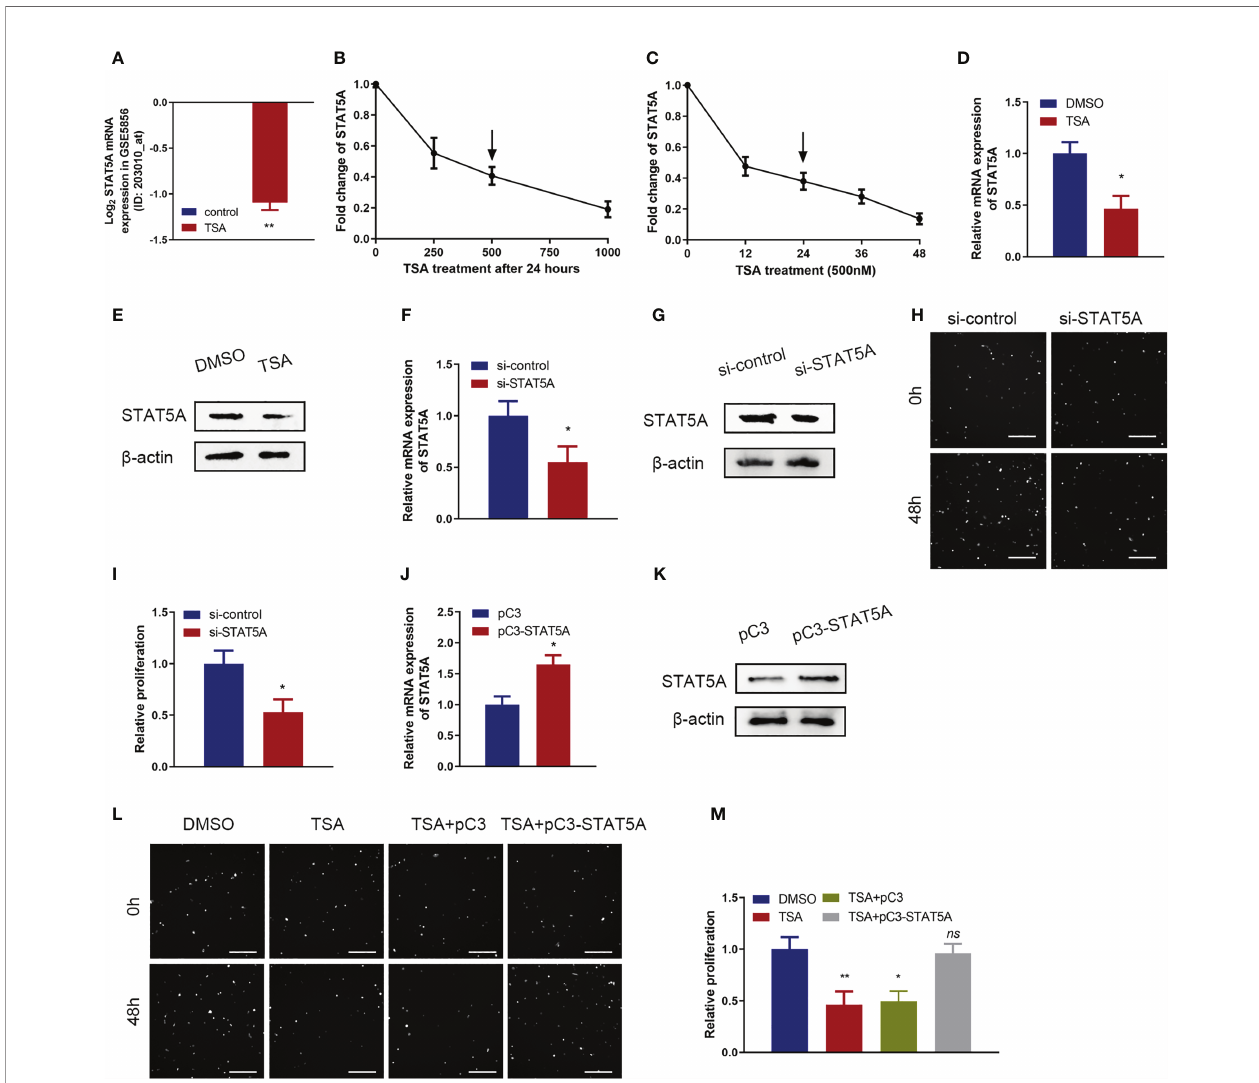
FIGURE 3 | Roles of signal transducer and activator of transcription 5 A (STAT5A) in cell proliferation inhibition of TSA on HUVECs. (A) Fold change of STAT5A expression in the microarray data (#GSE5856). (B, C) HUVECs were incubated with different doses of TSA (B) or for various durations of time (C) . mRNA expression of STAT5A was tested by qRT-PCR. (D, E) STAT5A mRNA level (D) and protein level (E) at 48 h after 500 nM TSA treatment were measured by qRT-PCR and Western blotting assay. (F, G) Knockdown ef fi cacy of siRNA transfection into HUVECs was analyzed by qRT-PCR (F) and Western blotting assay (G) . (H) HUVECs were transfected with si-STAT5A or si-control for 48 (h) Cell proliferation was examined with Cellomics ArrayScan VTI assay. Scale bar 400 m m. (I) Quanti fi cation of the data from (H) . (J, K) HUVECs were transfected with STAT5A plasmid (pC3-STAT5A) or empty plasmid (pC3) and then subjected to qRT-PCR analysis (J) and Western blot analysis (K) . (L) HUVECs were treated with DMSO, TSA, TSA+pC3, or TSA+pC3-STAT5A, and cell proliferation was analyzed by Cellomics ArrayScan VTI assay. Scale bar 400 m m. (M) Quanti fi cation of the data from (L) . * P < 0.05, ** P < 0.01 vs . the control group. ns, not signi fi